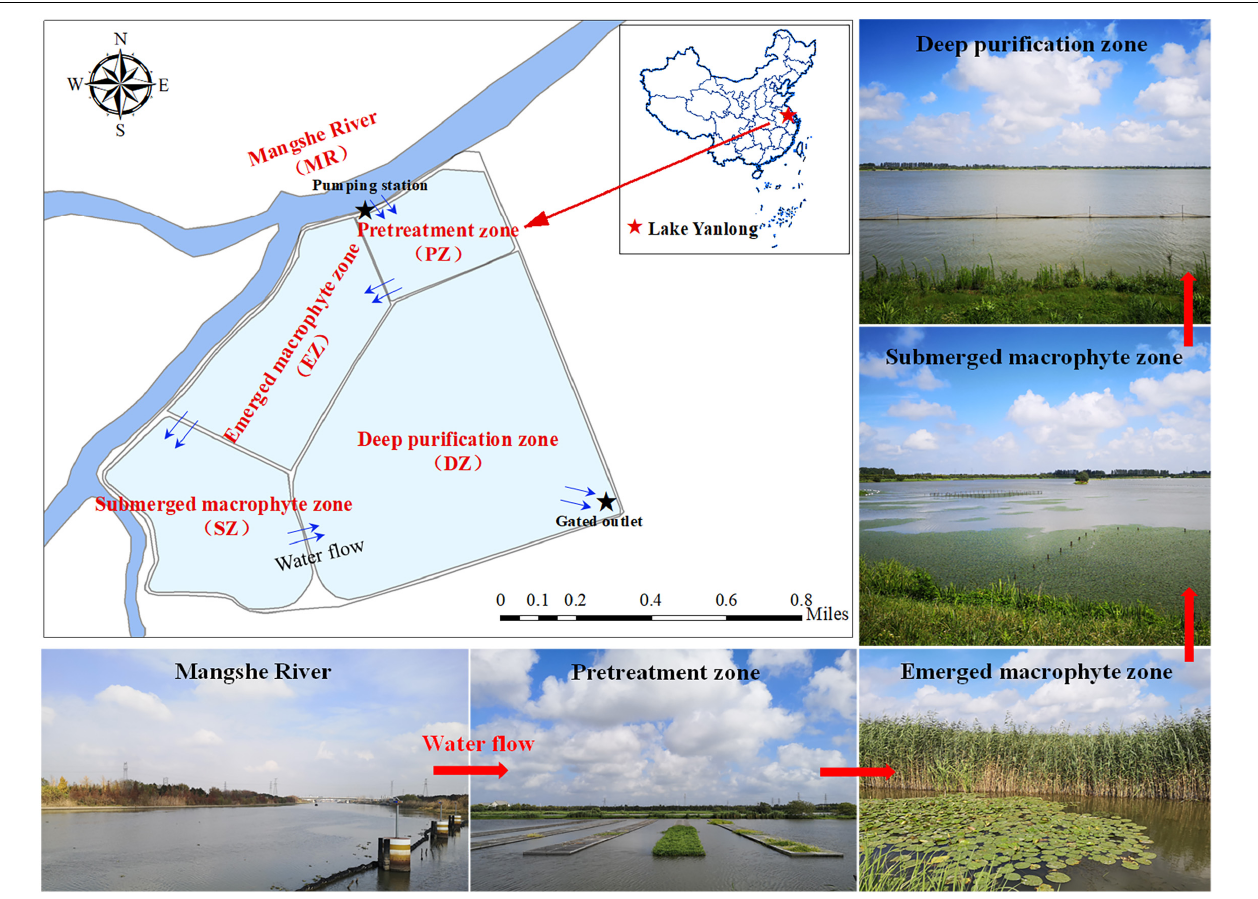
FIGURE 1 | Pictures and map of the Mangshe River (MR) and Lake Yanlong, showing the distribution of different purification zones (PZ, the pretreatment zone; EZ, the emergent macrophyte zone; SZ, the submerged macrophyte zone; DZ, the deep purification zone). TABLE 1 | Annual means ( ± SE) of physicochemical parameters measured in the Mangshe River (MR) and different purification zones of Lake Yanlong (PZ, the pretreatment zone; EZ, the emergent macrophyte zone; SZ, the submerged macrophyte zone; DZ, the deep purification zone).